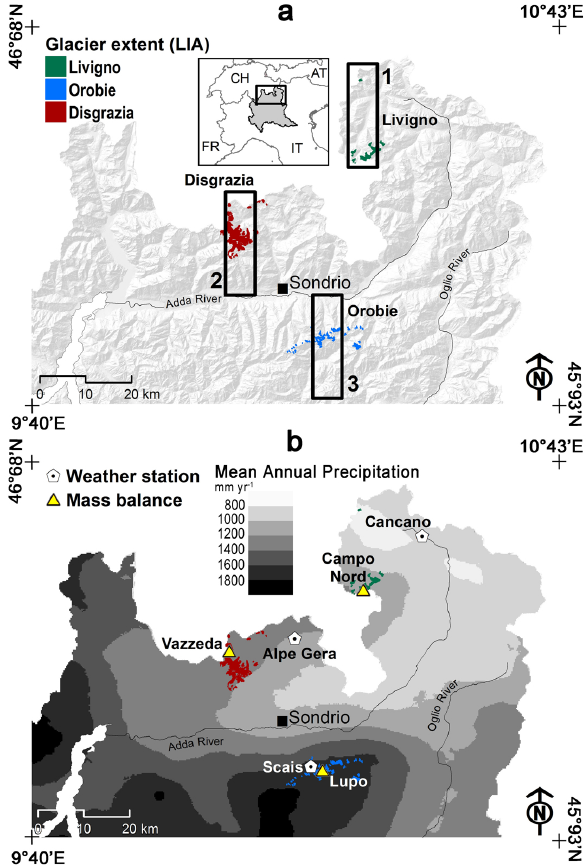
Figure 1. Maps of northern Lombardy showing (a) the three sub- region location and the transects used to create the swath profiles (see Fig. 4) and (b) spatial distribution of mean annual precipitation with sample weather stations and mass balance measured glaciers (see text for further details). Mean annual precipitation was interpo- lated by using ordinary co-kriging with 374 rainfall stations (1981– 1990) (Ceriani and Carelli, 2000) and 50000 elevation points ran- domly distributed within the